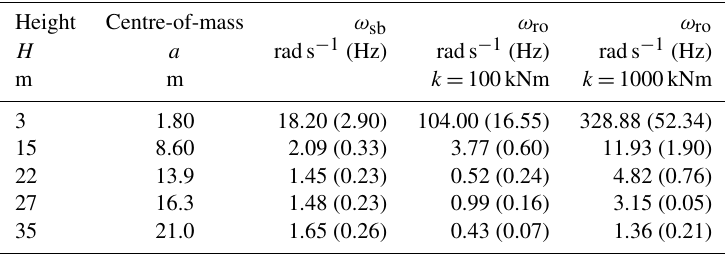
Table 2. Natural frequencies in bending and overturning for spruce trees of different heights. E = 10GPa. A reduced stem diameter d = 0.5 d DBH produces a good agreement to measured frequencies. Mass distribution taken from Table 1.